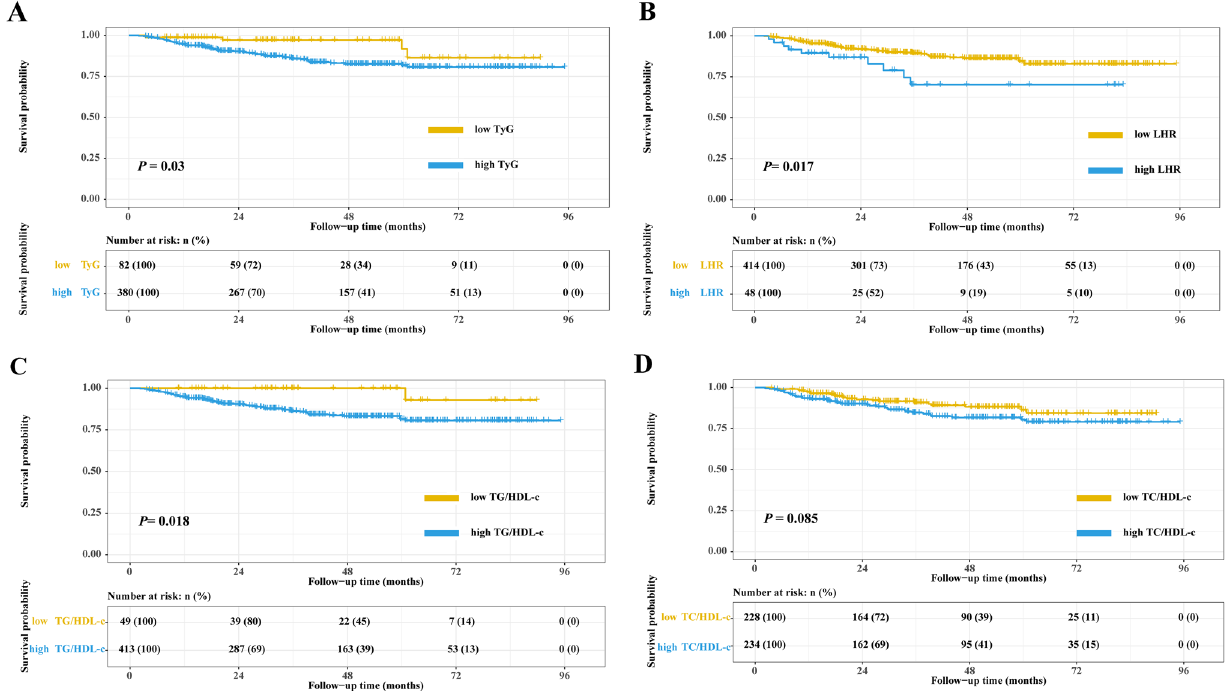
Figure 5. The Kaplan–Meier survival curves of IR makers in women with breast cancer. ( A ) TyG; ( B ) LHR; ( C ) TG/HDL-c; ( D ) TC/HDL-c. Notes IR insulin resistance, TyG triglyceride-glucose index, LHR LDL-c/HDL-c ratio, HDL-c high-density lipoprotein cholesterol, LDL-c low-density lipoprotein